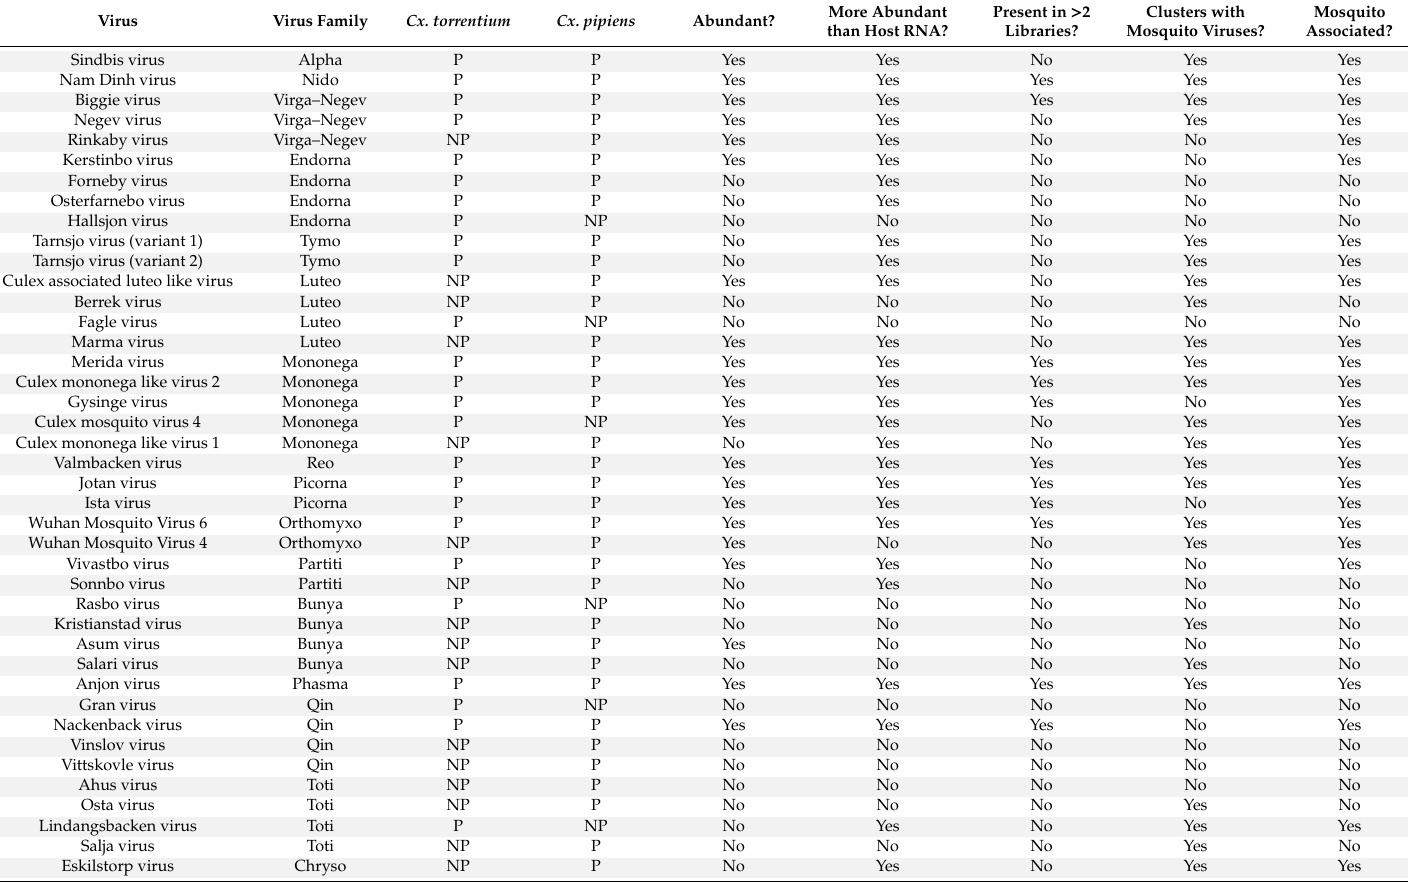
Table 3. Indication of host associations for the viruses discovered here. Likely host association was assessed using (i) the abundance of viral contig per total amount of reads in a library, (ii) virus abundance in relation to the host COX1 gene, (iii) presence across libraries, and (iv) phylogenetic clustering with other mosquito-derived viruses. If a particular virus met two or more of the four criteria, it was considered as a mosquito-associated